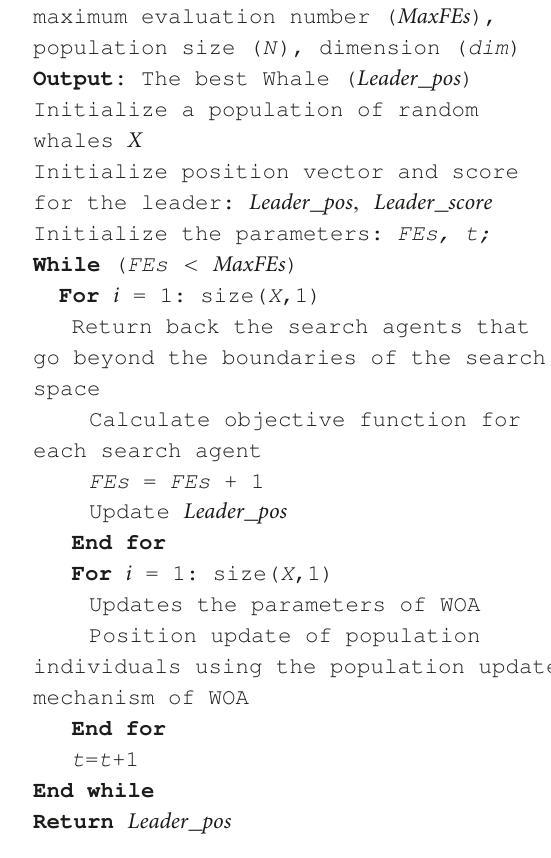
Algorithm 1. Pseudocode for the traditional